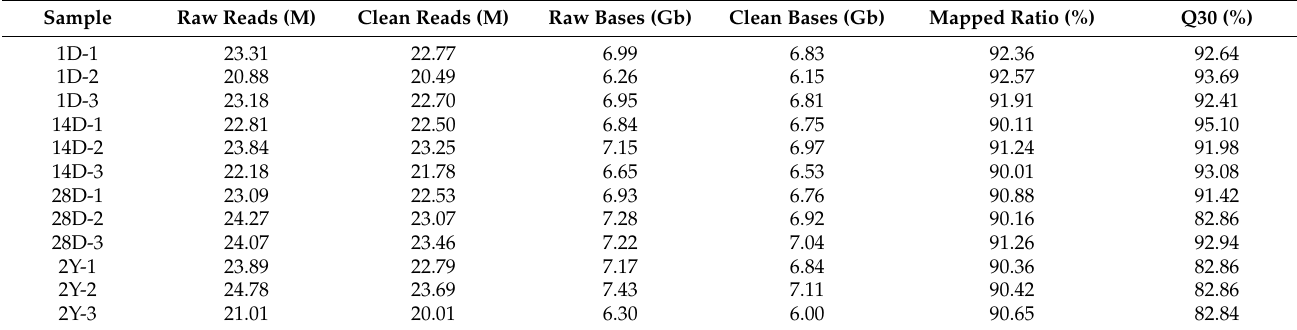
Table 1. RNA-Seq data from breast muscle of White-King